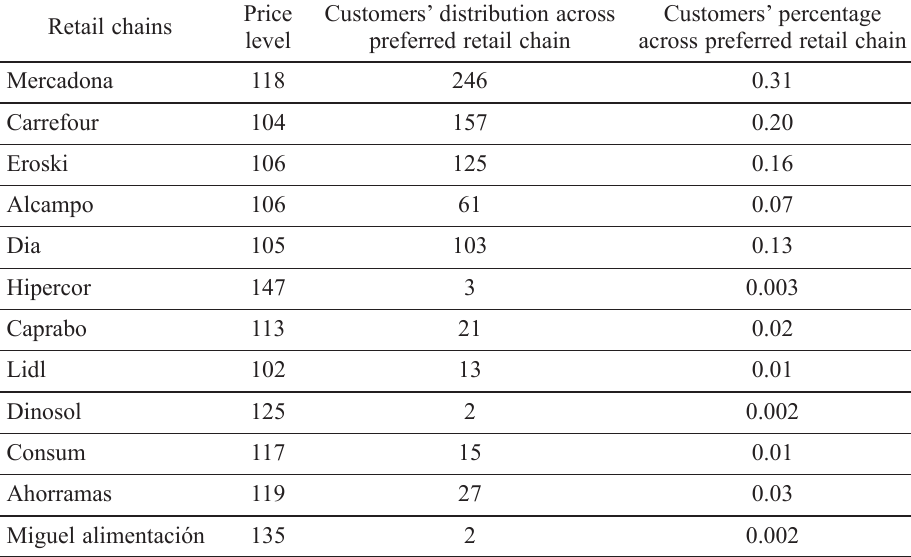
Table 2. Price level and customer distributions across retail